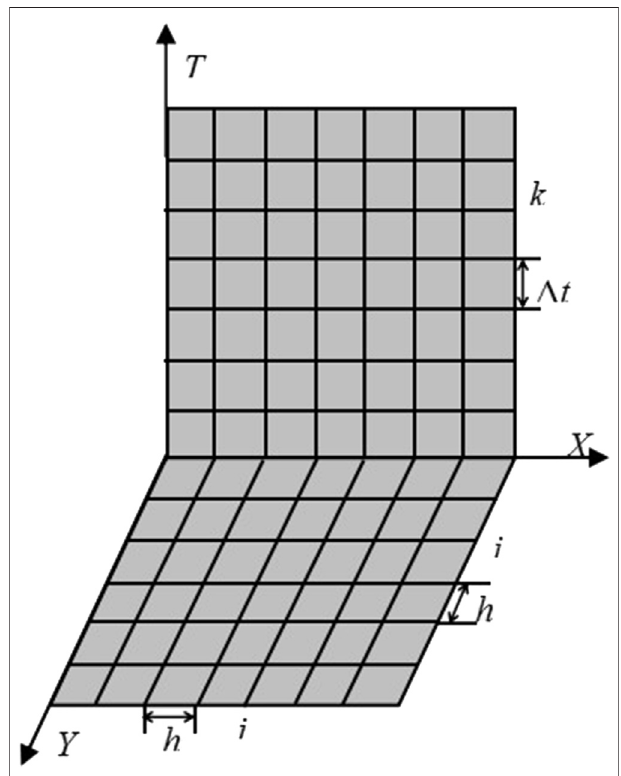
FIGURE 6 | Mesh generation of 2D solution